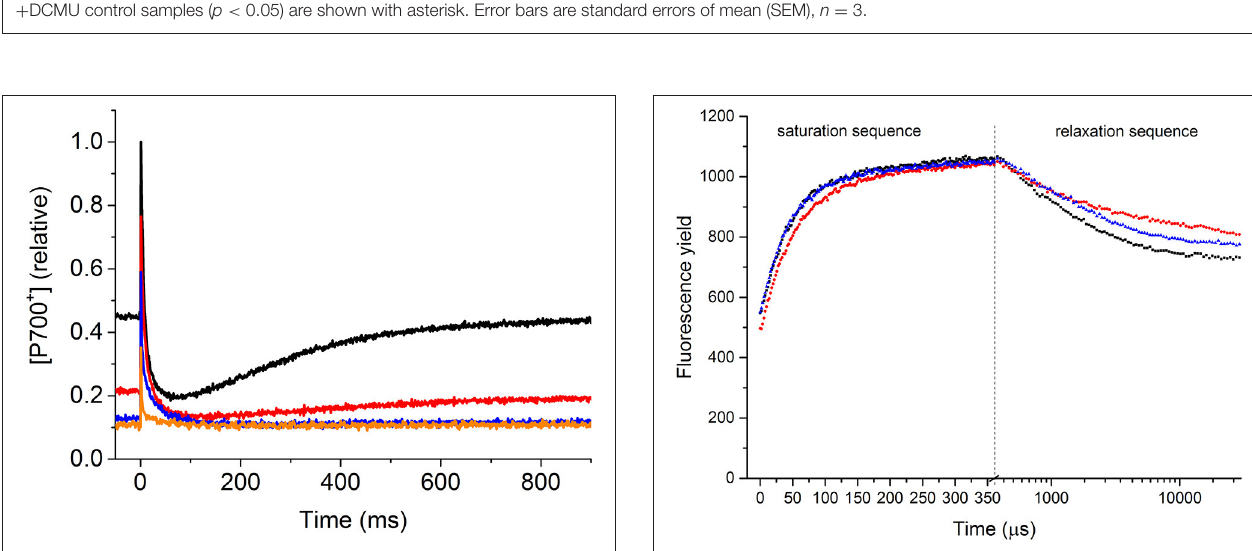
FIGURE 6 | Representative FRRf saturation-relaxation fluorescence traces of P. decussata . Measurements were done at 25 ◦ C (control, black line), at 33 ◦ C (heat, red line), and 25 ◦ C after the heat treatment (recovery, blue line). Saturation sequence is displayed on a linear timescale, whereas relaxation sequence is on a log 10 timescale (the two sequences are visually separated with a dashed line). Y axis represents fluorescence